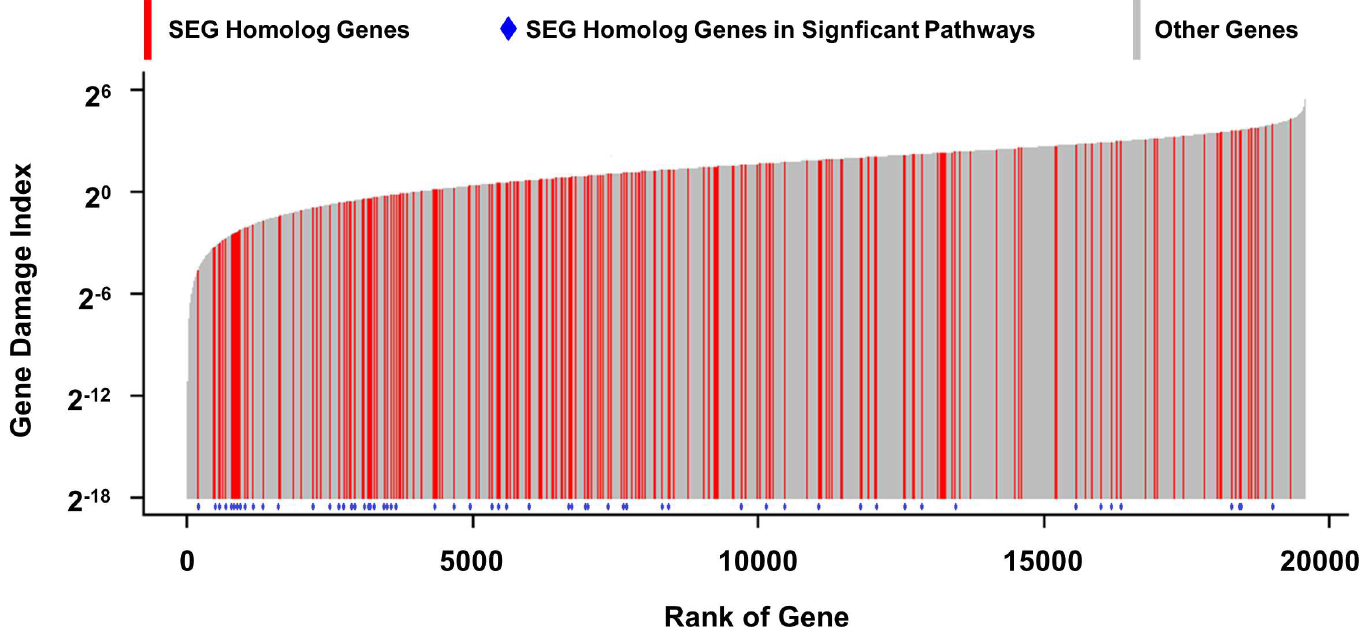
Fig 4. Human homolog genes of SEGs showed significantly lower Genetic Damage Index (GDI). Each bar representeda gene, with the height corresponding to the GDI value. The SEG homologs are red and those associated with significantpathways identifiedin Table 1 are marked with a blue